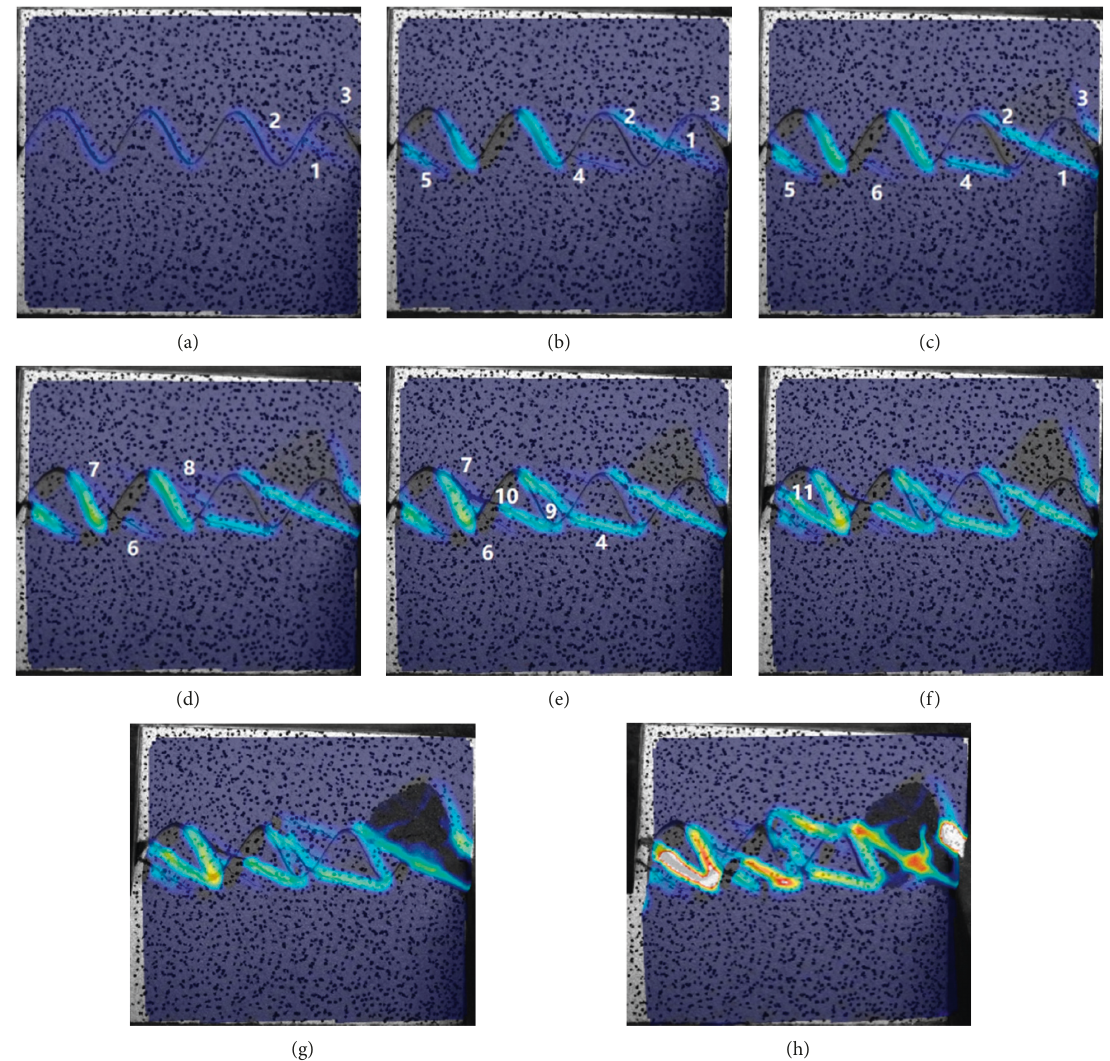
Figure 9: Failure process of the specimen with an undulated height of 15mm under DIC